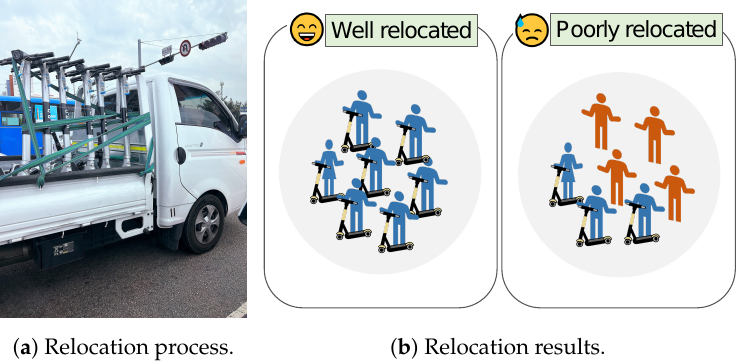
Figure 2. An illustration of E-scooter relocation. As collecting and relocating many E-scooters from various places requires significant costs, an E-scooter vendor should carefully determine where and how many E-scooters to relocate to improve the usage ratio to compensate the relocation costs.